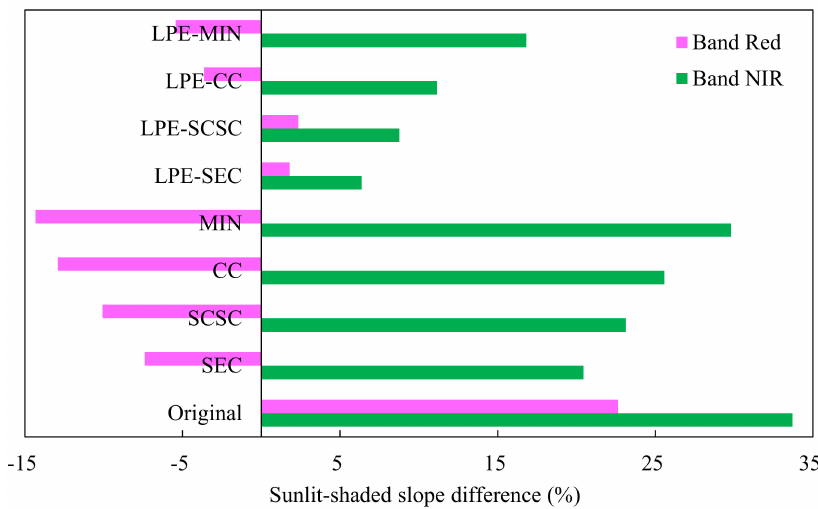
Figure 5. The reflectance di ff erence of the coniferous forests on sunlit-shaded slopes (wm − 2 sr − 1 µ m − 1 ) between the traditional TC models and the LPE-TC models. The smaller the di ff erence, the better the correction result.